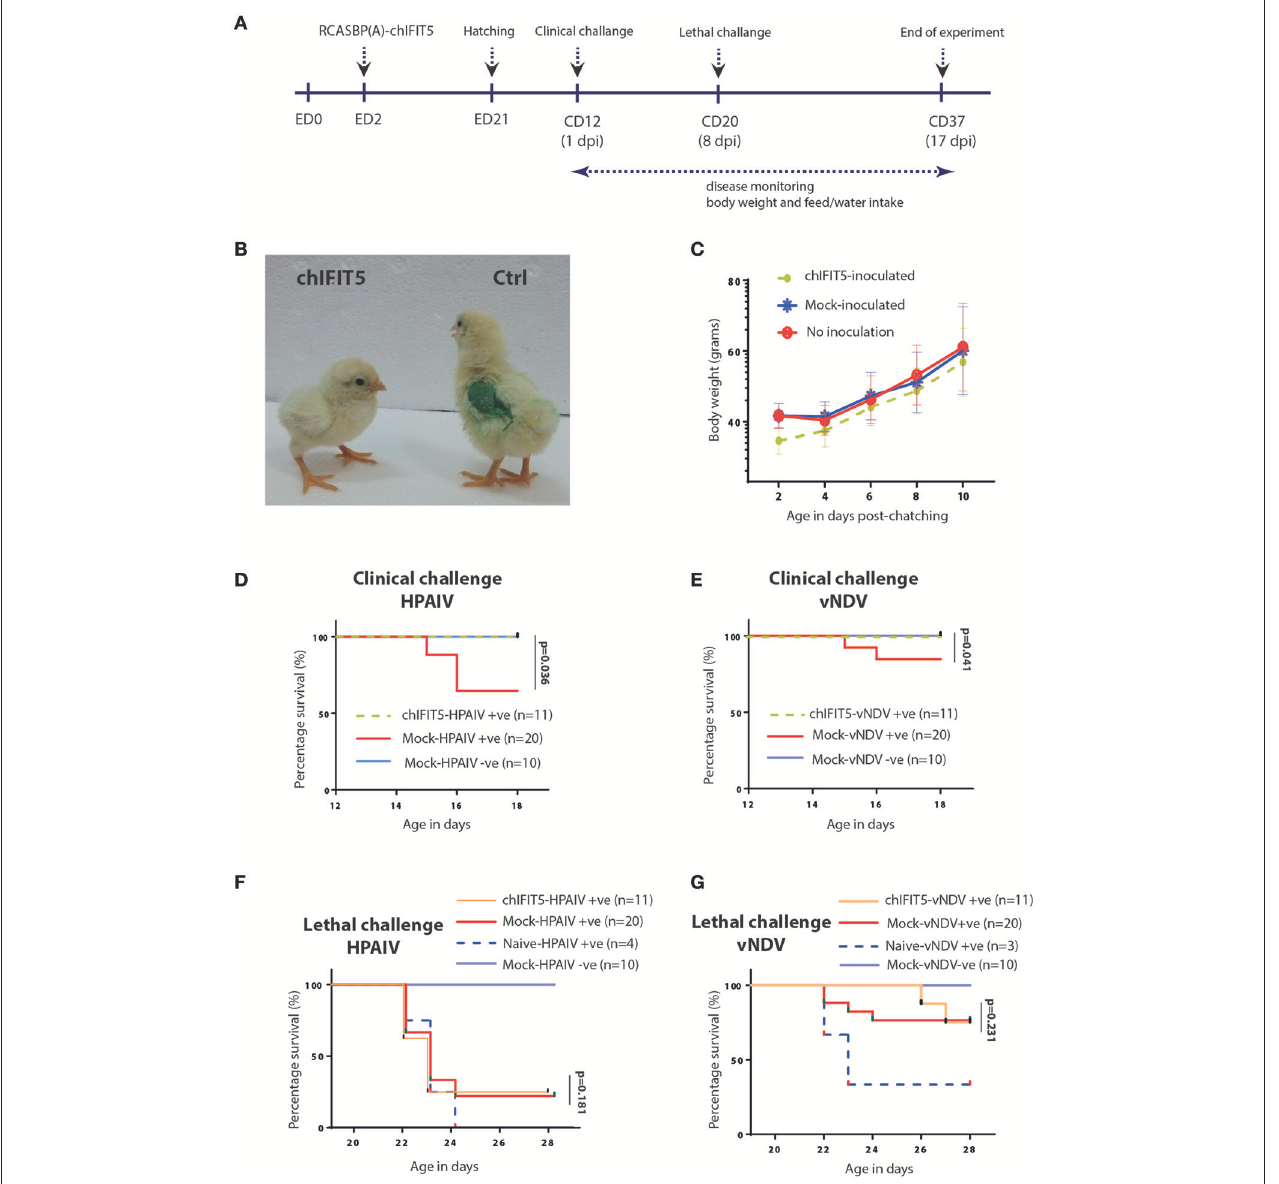
FIGURE 3 | Generation of transgenic chickens and impact of chIFIT5 on physiological parameters of chicken. (A) Schema representing the time of transgenesis and challenge experiment. (B) Comparison of the body mass of chIFIT5 expressing transgenic chicken and control chicken. (C) Wait gain in transgenic and control chickens post-hatching and pre-challenge. (D) Survival curve of chickens against clinical dose of HPAIV, (E) vNDV, (F) lethal dose of HPAIV and (G)